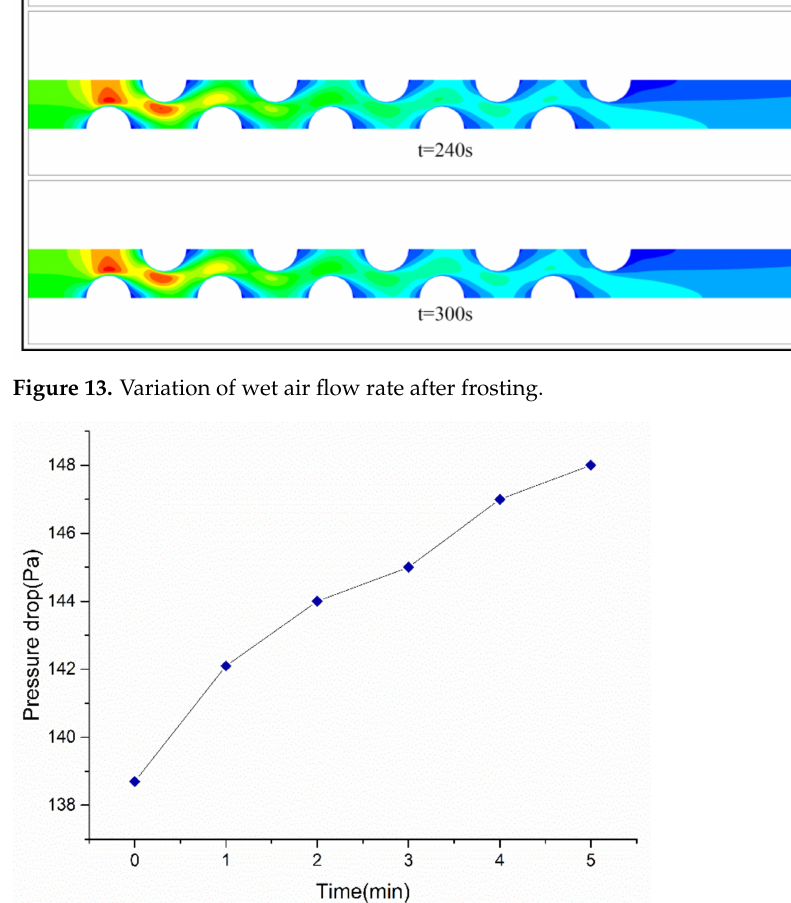
Figure 14. Pressure drop after